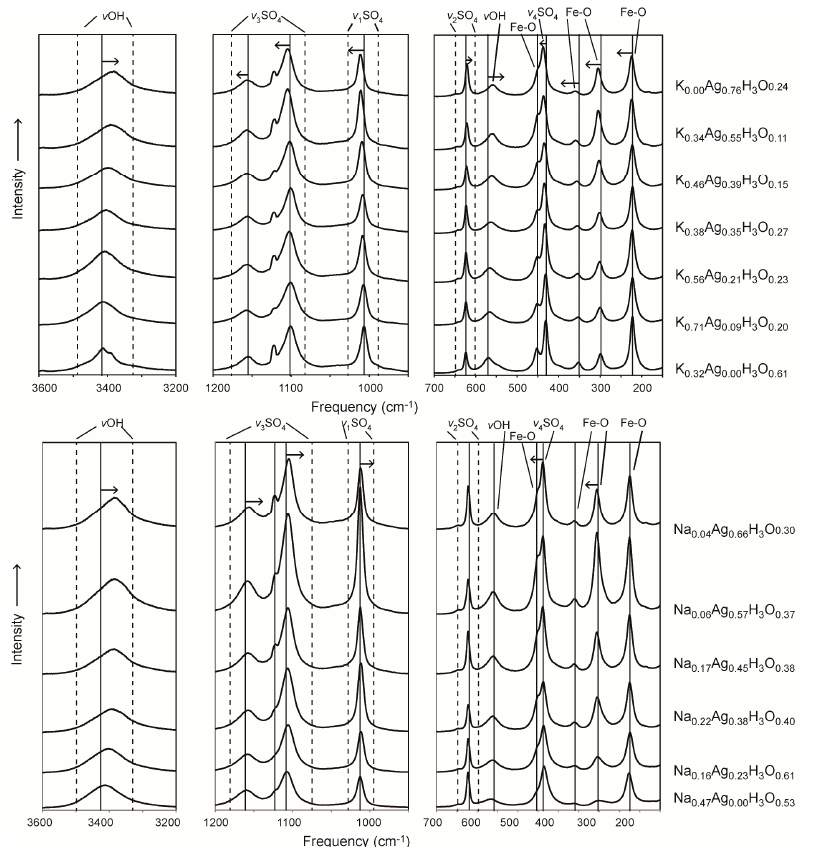
Figure 6. Raman spectra for K-Ag-H 3 O and Na-Ag-H 3 O compounds synthesised at 140 °C and dried at 110 °C.